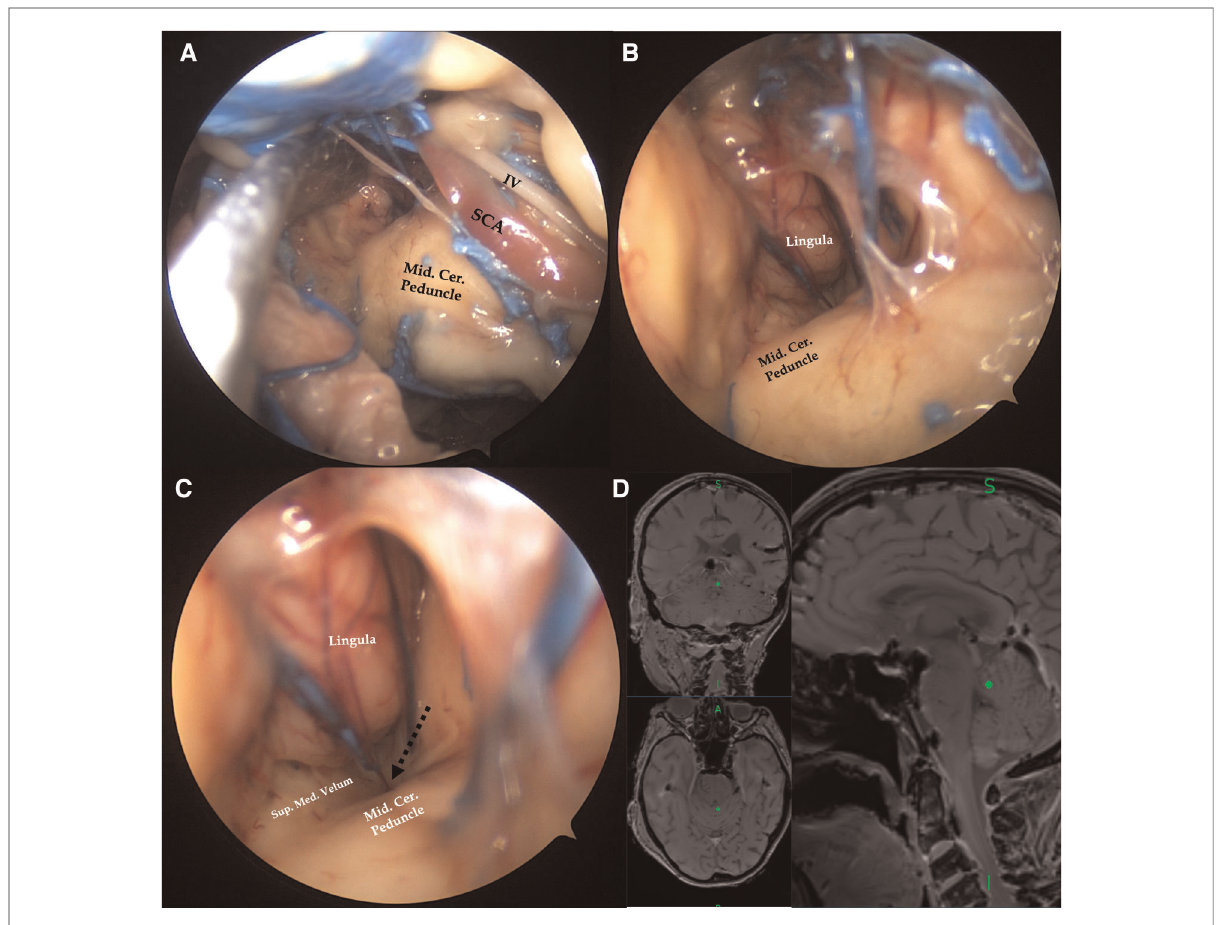
FIGURE 6 Right endoscopic transorbital exposure of the tentorial incisura and cerebellomesencephalic fi ssure. Extending forward arachnoid dissection of the cerebellopontine fi ssure, the middle cerebellar peduncle is divided from the petrosal surface of the cerebellum ( A ). By inserting a 30°endoscope along the superior margin of the middle cerebellar peduncle and directing the light inferiorly, the posterior margin of the cerebellomesencephalic fi ssure, represented by the lingula of the cerebellum, and the external surface of the superior part of the roof of the fourth ventricle (black dotted arrow), represented by the superior medullary velum, are visualized ( B,C ). We con fi rmed our anatomic fi ndings by pointing the navigator (Medtronic StealthStation) at the level of the lingula ( D ). IV, cisternal portion of the trochlear nerve; Mid.Cer.Peduncle, middle cerebellar peduncle; SCA, superior cerebellar artery; Sup.Med.Velum, superior medullary velum.